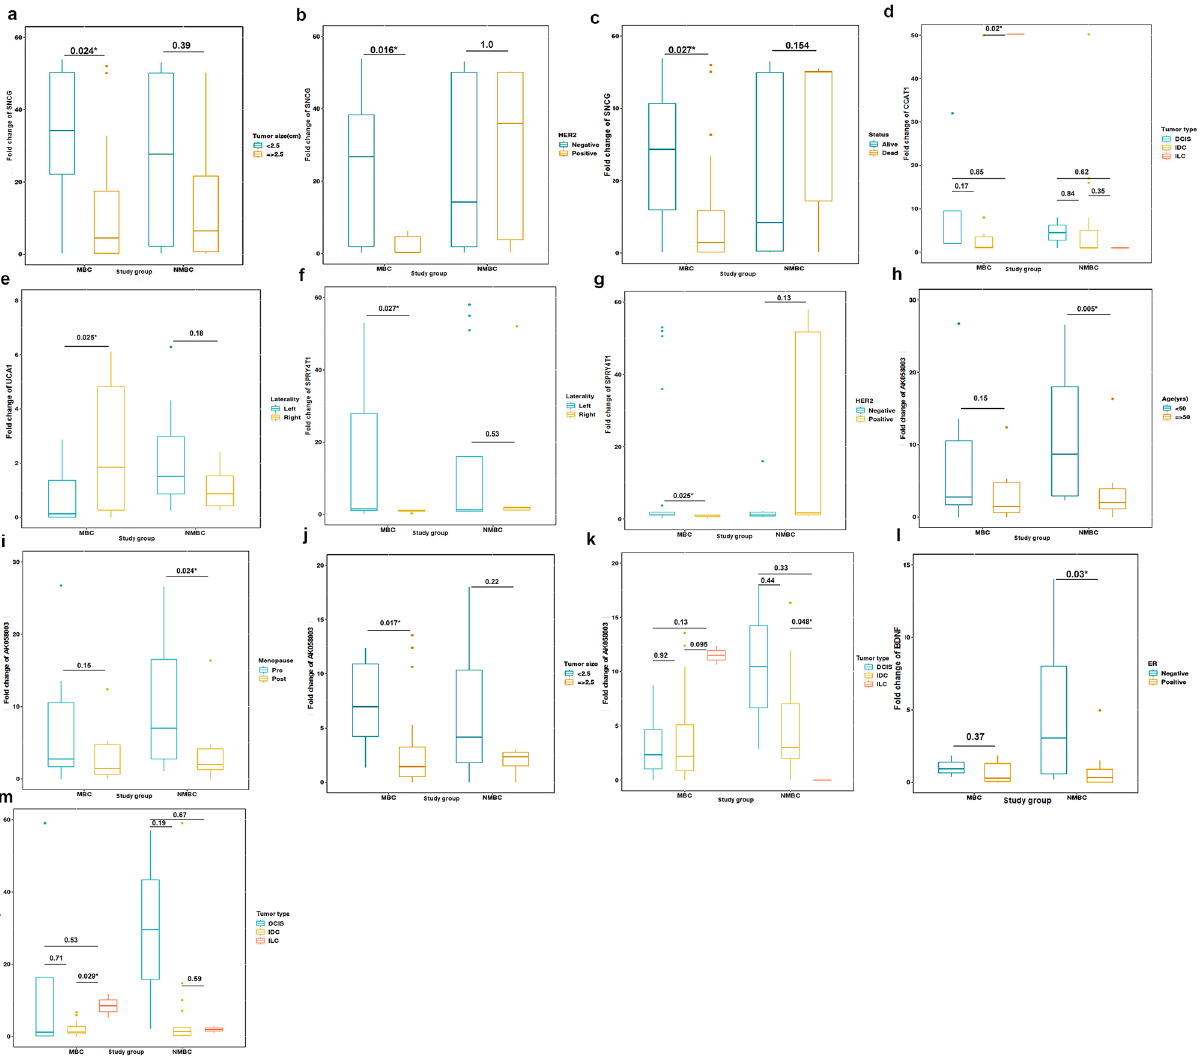
Figure 2. Clinicopathological features were significantly associated with lncRNAs/ mRNAs ( a–c ) SNCG with tumor size, HER2 overexpression and live status, ( d ) CCAT1 with tumor type, ( e ) UCA1with laterality, ( f, g ) SPRY4T 1 with laterality and HER2 overexpression, ( h–k ) AK058003 with age, menopause, tumor size and type, ( l ) BDNF with ER expression and ( m ) MALAT1 with tumor